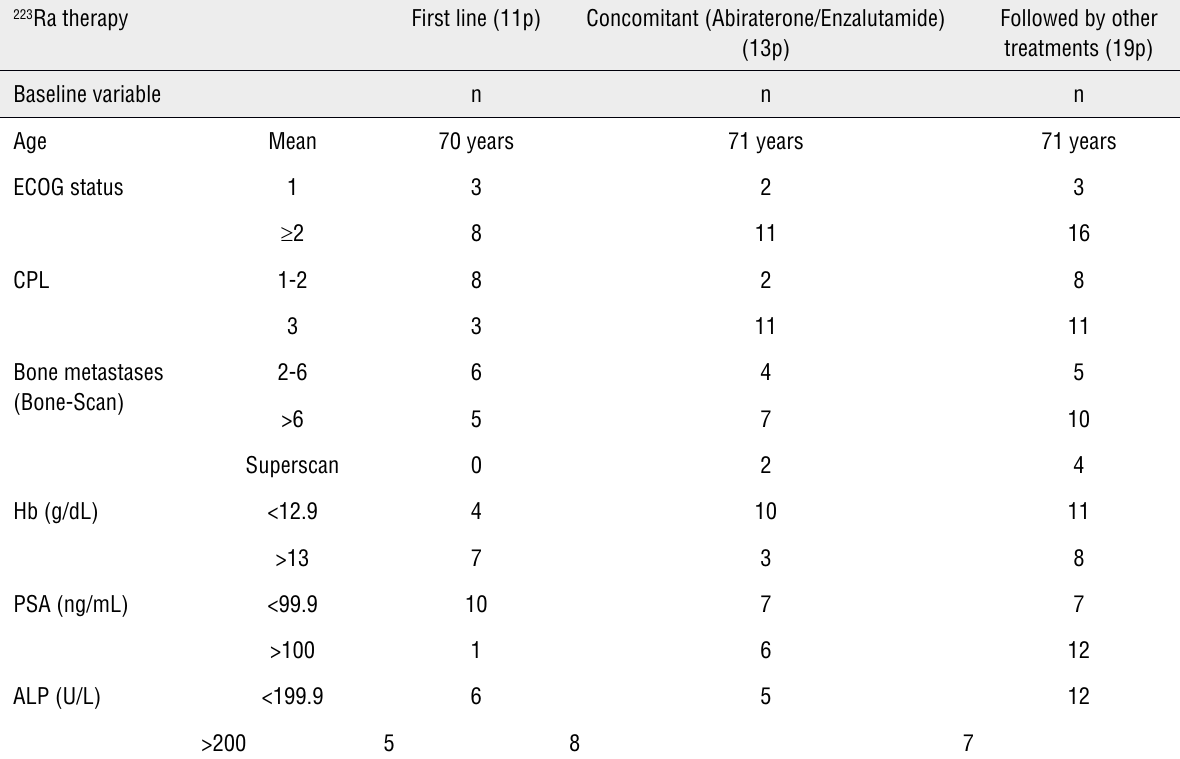
Table 6 - Patients´ baseline characteristics of treated with 223Ra in the 3 lines of therapy. 223 Ra therapy First line